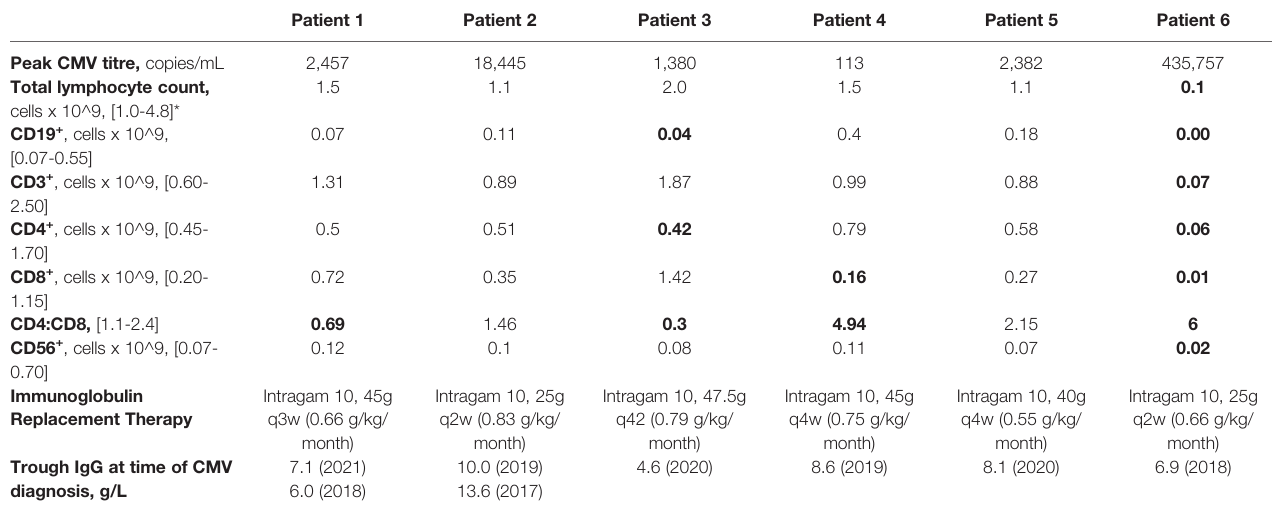
TABLE 2 | CVID + /CMV + cohort: immunological